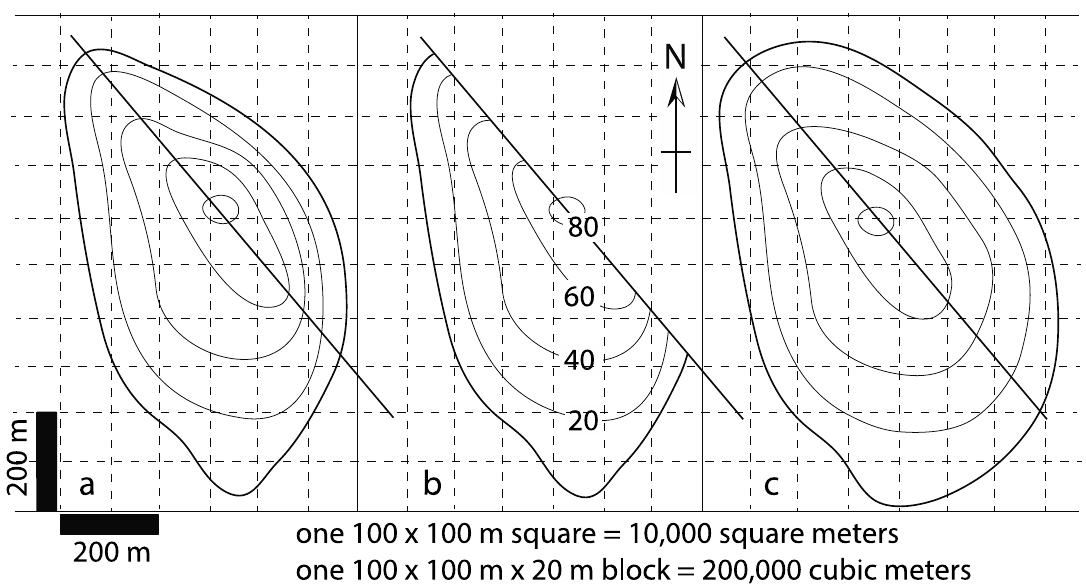
Figure 11. Progression of stages in geomorphological modeling with respect to the un-named islet between barriers # and #2; ( a ) Topography of present day islet with dividing line showing disparity between the gentler lagoon side and exposed cliff face on the open sea; ( b ) Erasure of the outer cliff face; ( c ) Restoration of past topographic gradient on the seaward face showing a better match with the sheltered side.